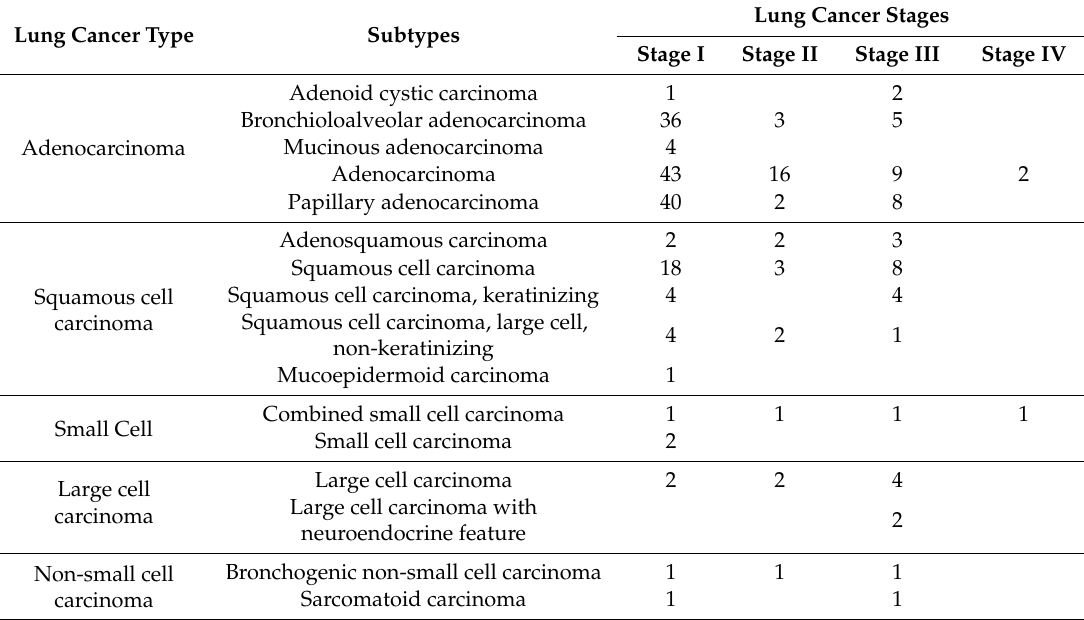
Table 2. Types, subtypes, and stage-wise distribution of lung cancer ( n = 244) samples. Lung Cancer Type